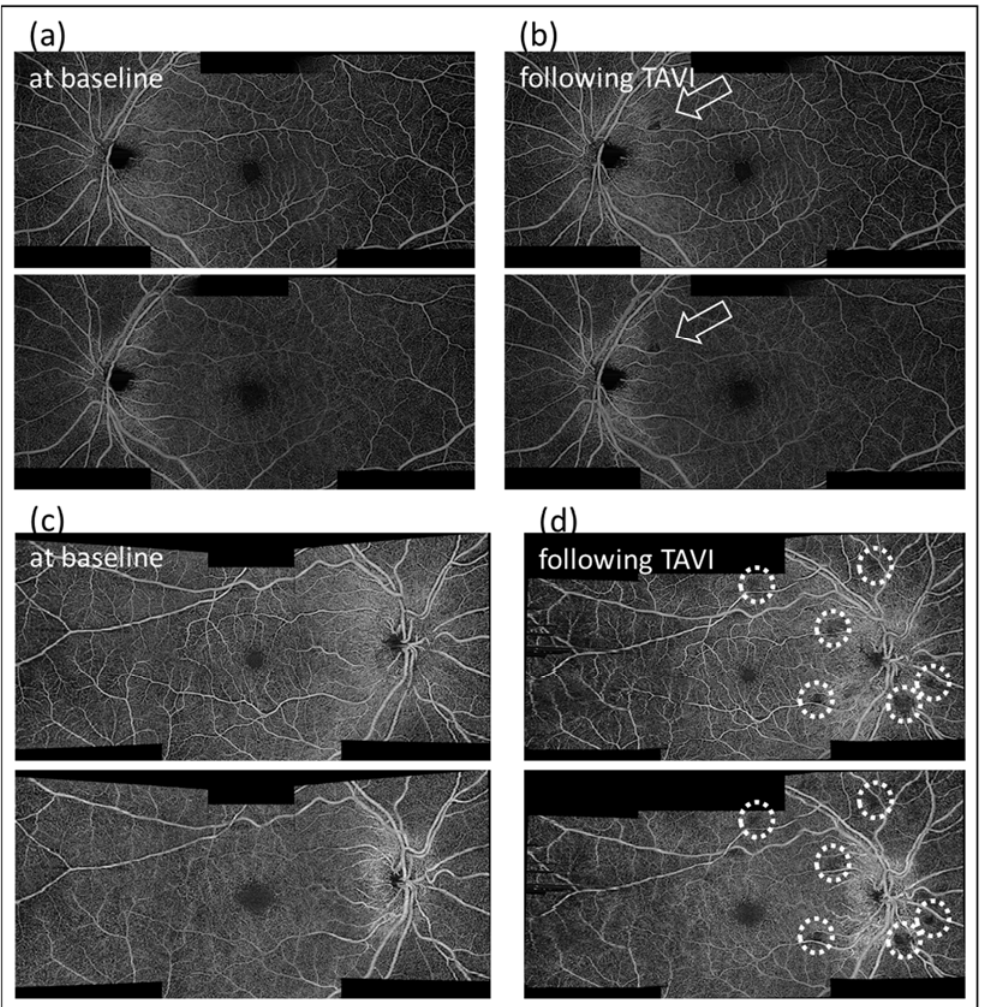
Figure 2. Examples of capillary dropout lesions on OCTA. ( a ) and ( c ) are images acquired at baseline of two exemplary cases (71 ‐ and 76 ‐ year ‐ old patients, both male). These posterior pole images are reconstructed from three individual 6 × 6 mm scans—a macular, a temporal and a papillary scan of the superior and deep capillary plexus. ( b ) post-TAVI OCTA reconstructed image of the same subject as image ( a ), presenting a singular capillary dropout lesion (arrow). ( d ) Post-TAVI OCTA reconstructed image of the same subject as image ( c ), presenting multiple capillary dropout lesions (circles). Please also note the motion artifacts on the temporal (left) edge of the image ( d ), which present as horizontal lines/image shifts due to the image acquisition in horizontal line scans (in Plex Elite 9000). These motion artifacts were more prevalent in peripheral scans, most likely as it is more difficult to keep the gaze steady in non-central fixation. These motion artifacts are very recognizable and distinctive from the drop out lesions, which are roundish and do not show horizontal borders and are not in extension of the horizontal lines.